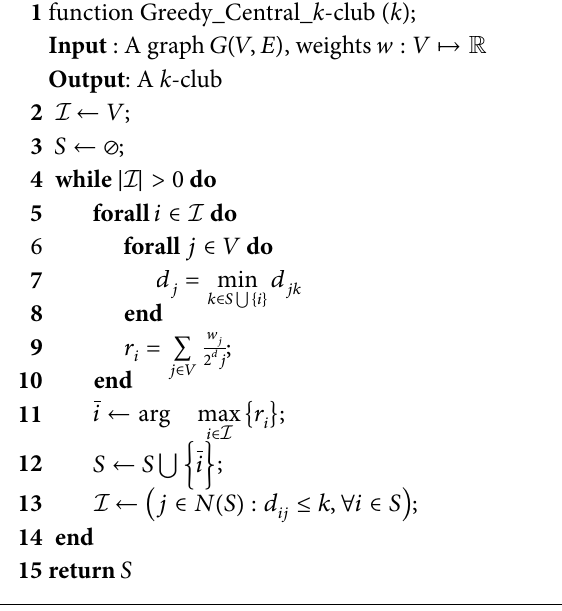
Algorithm 1: Greedy Central k